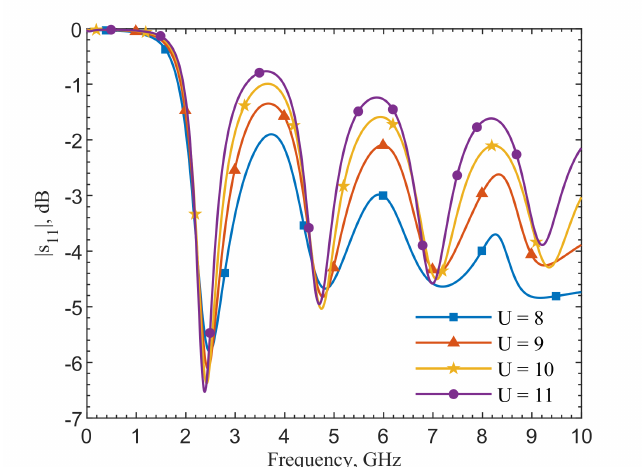
Figure 2. ( a ) Loop resonator configuration. b is the radius; 2 a is the planar loop width. ( b ) Photo of a loop resonator for measurement in which U = 9, b = 20.9 mm, and a = 1.44 mm. The metal thickness is 0.0345 mm.